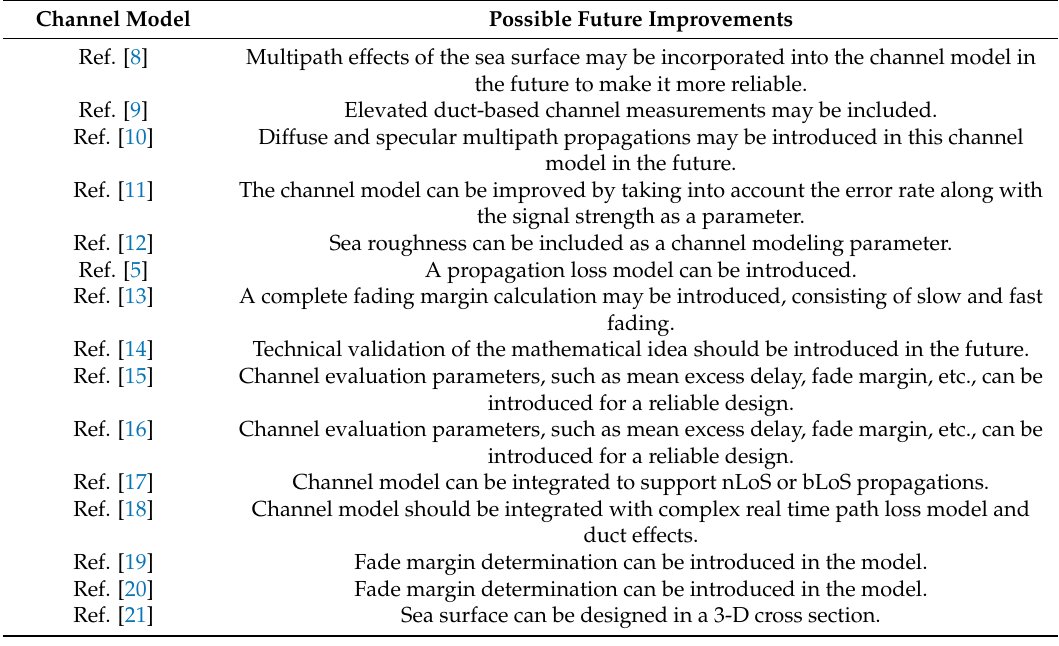
Table 5. Possible future improvements of the channel